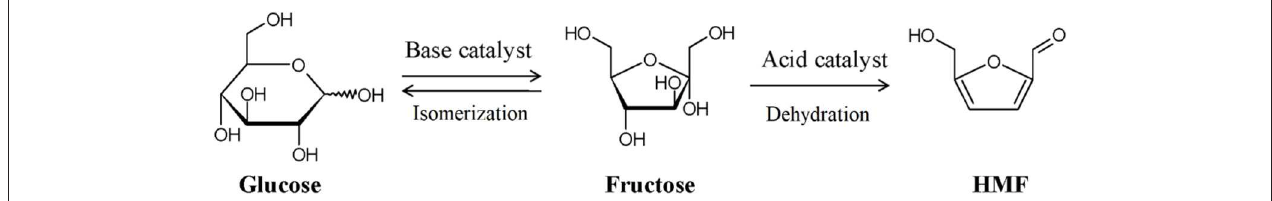
FIGURE 8 | General process of LA production from cellulose. Used with permission of Royal Society of Chemistry, from Takagaki et al. (2009); permission conveyed through Copyright Clearance Center, Inc.